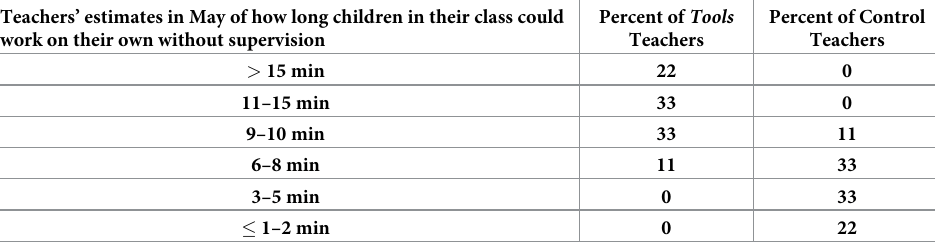
Table 2. Teachers’ responses to the question, "If someone comes in your room now [in May], how long do you feel you could talk with that person and let the children in your class work on their own without supervision?". Teachers’ estimates in May of how long children in their class could work on their own without